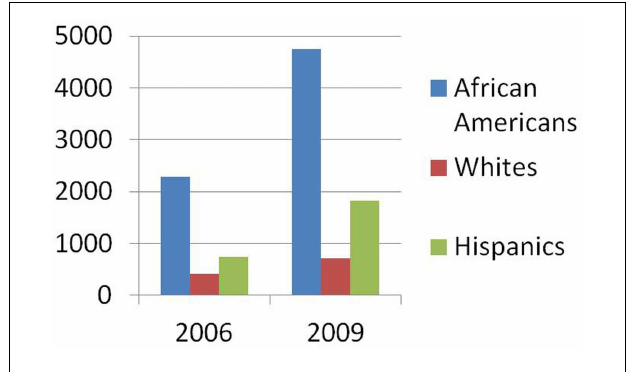
FIGURE 1 | Comparison of incarceration rates amongAfrican Americans,Whites and Hispanics in 2006 and